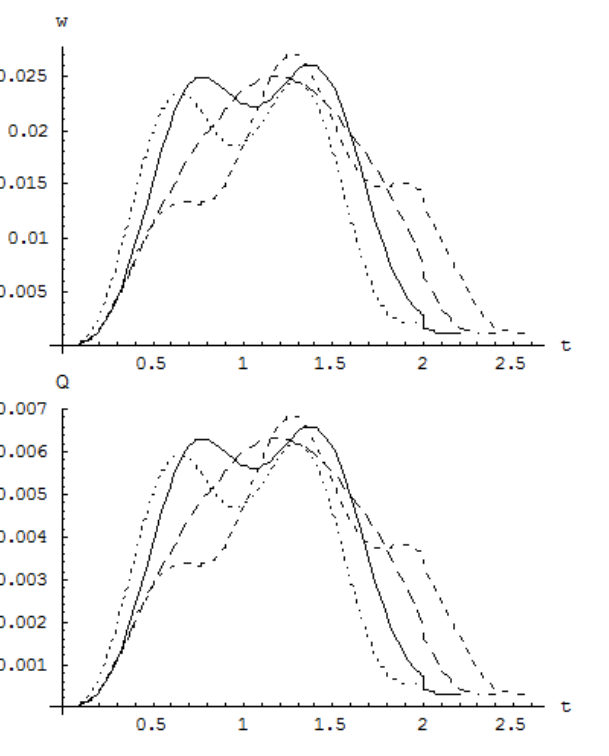
Figure 29: The influence of the vehicle length for R = 150 m, υ = 30 m/s, e H = 3.00 m, e V = 1.20 m and d = 3 m ( __ ), d = 5 m ( _ _ ), d = 7 m (- - - ) and d = 0 m ( ....